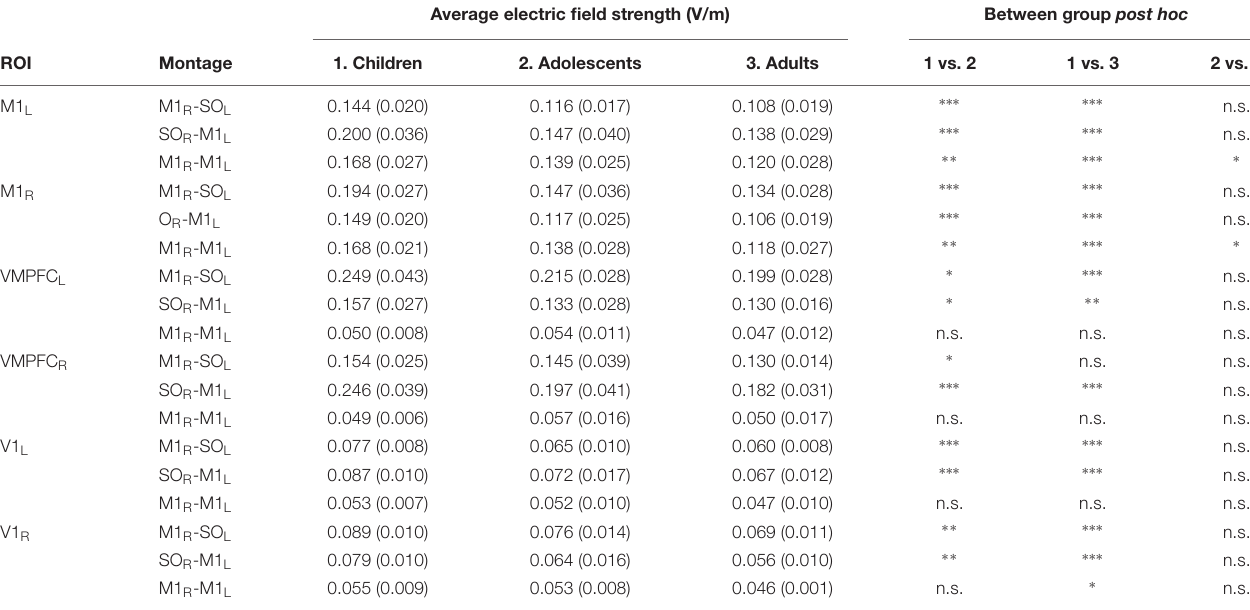
TABLE 3 | Average electric field